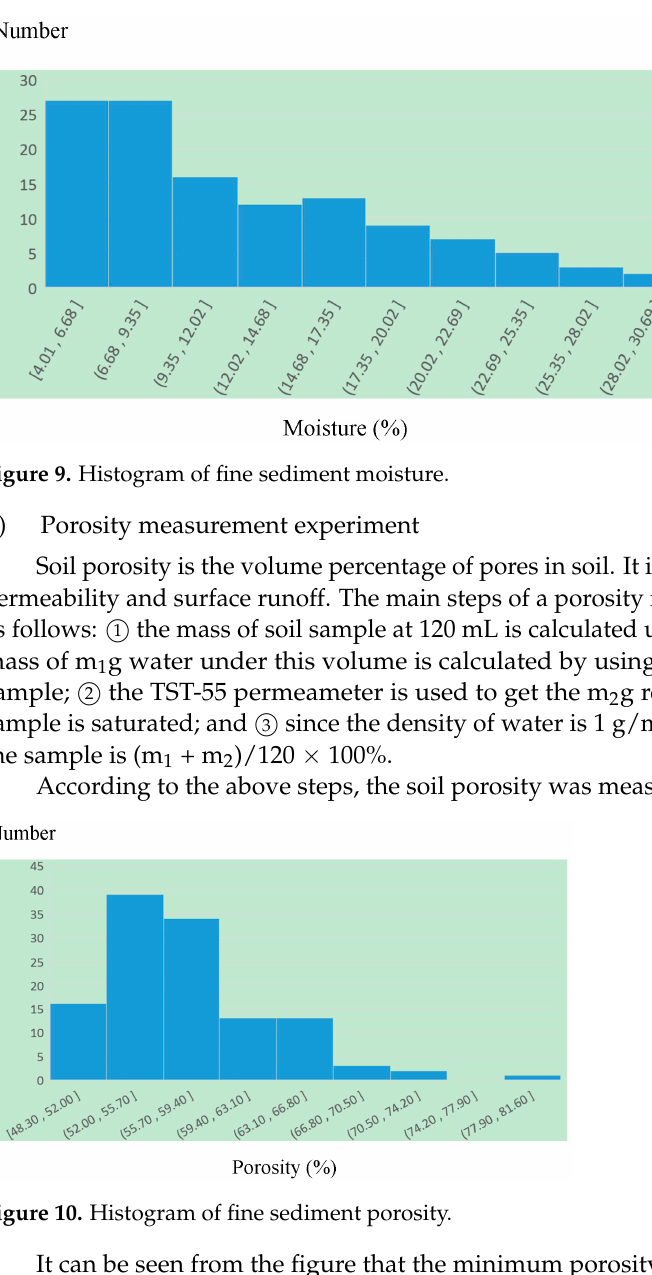
Figure 11. Principle of the ZJ strain-controlled direct shear instrument. The steps are as follows: ① correct the lever to be horizontal; ② calculate the weight of the sample according to the volume of the ring knife of the direct shear instru- ment and the soil density, making a suitable sample for the shear instrument with its ring knife and then placing the shear box in the sliding frame, and pushing the soil sample into the shear box; ③ cover the cutting box, and press the screw on the cover; ④ tighten the force measuring ring and adjust the dial indicator to zero; ⑤ add weight loads or their combinations to the lever to obtain a series of shear normal stress of 50, 100, 200, and 300